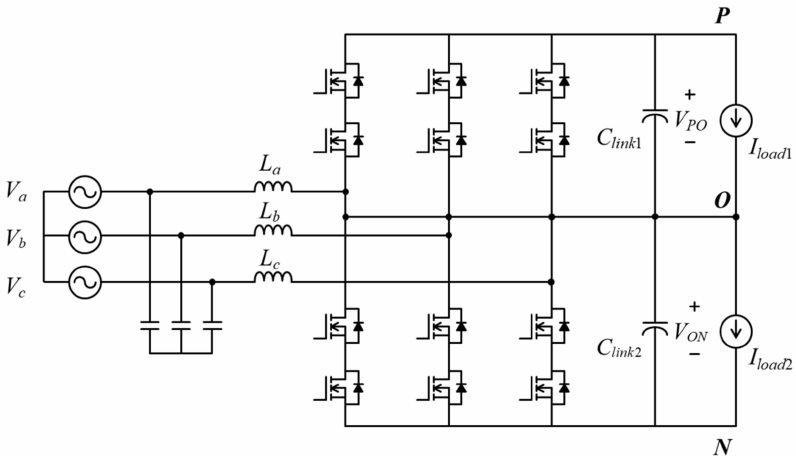
Figure 5. Power stage configuration of three-level NPC converter.